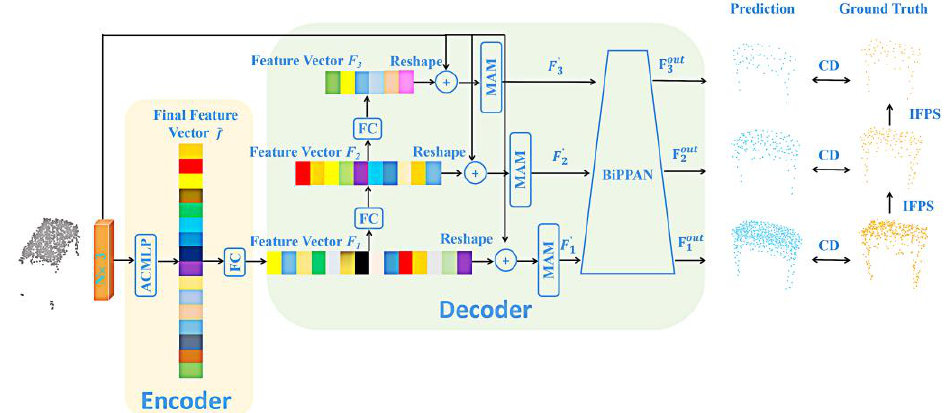
Figure 2. Illustration of our framework. The encoder (yellow) adopts ACMLP to extract features from input point clouds. The decoder (green) adopts BiPPAN with skip connections to predict the multiscale missing parts. Then, the Chamfer Distance errors of the prediction point cloud and ground truth are